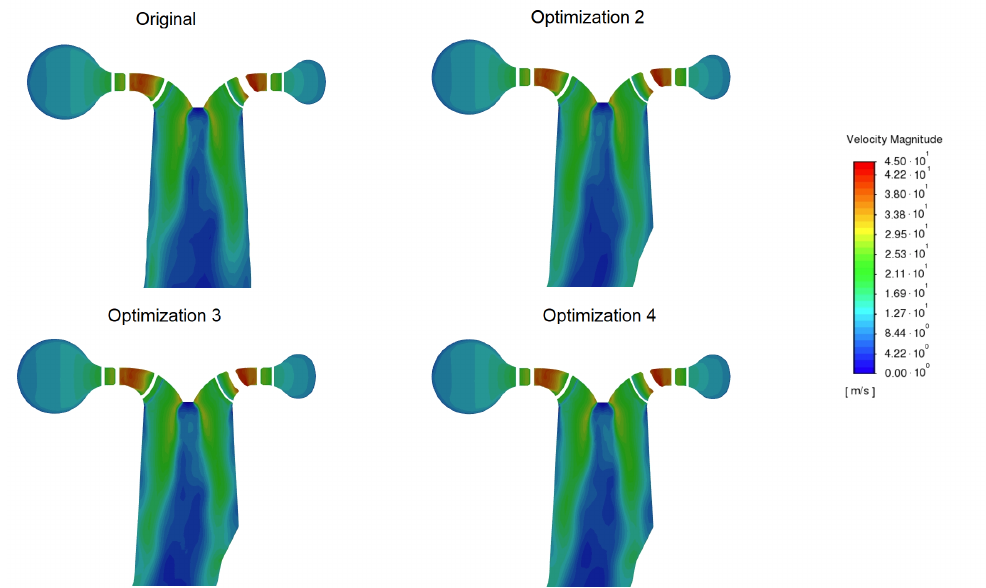
Figure A8. Detail of the velocity magnitude at the beginning of a draft tube for a 12.8 m 3 /s flow rate.